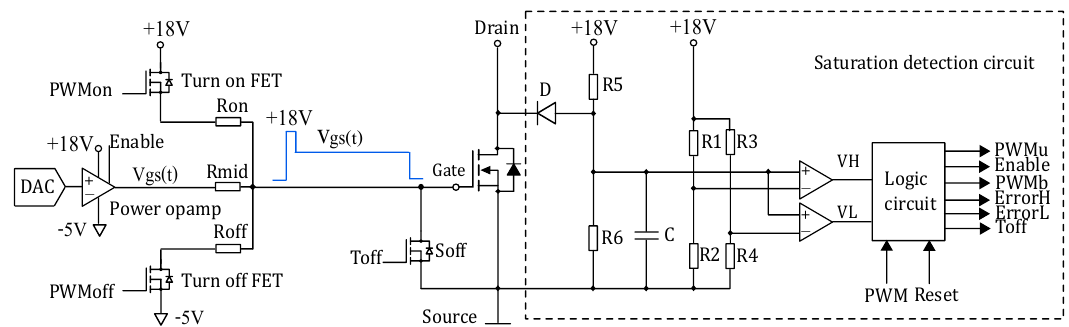
Figure 11. Three-level dynamic gate driver schematics.